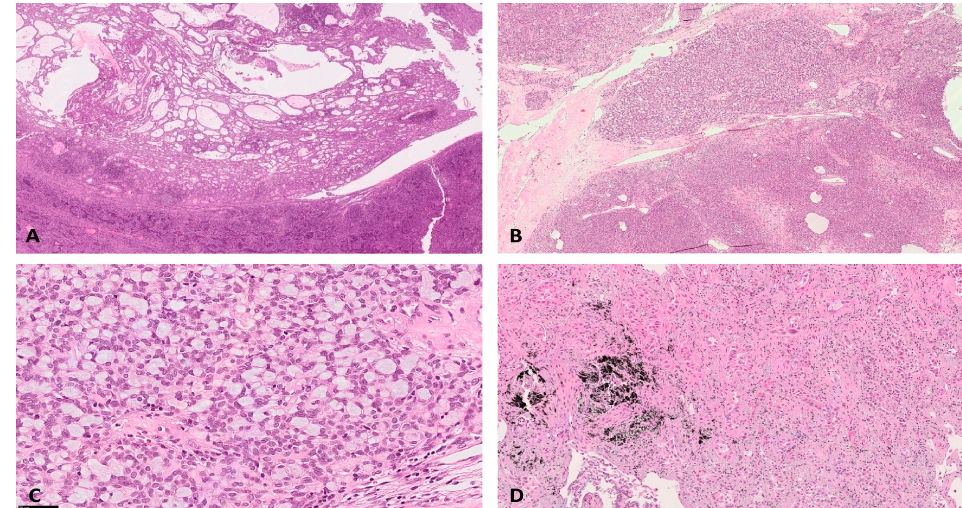
Figure 3. Formalin fixed-paraffin embedded (FFPE) sections showing microcystic AB Type Thymoma ( A : Ematoxylin/eosin, 5×), microcystic AB Type Thymoma with signet ring-like cells features ( B : Ematoxylin/eosin, 5×); signet ring-like cells in Thymoma ( C , Ematoxylin/eosin, 40×) and pulmonary adenocarcinoma ( D : Ematoxylin/eosin, 20×).